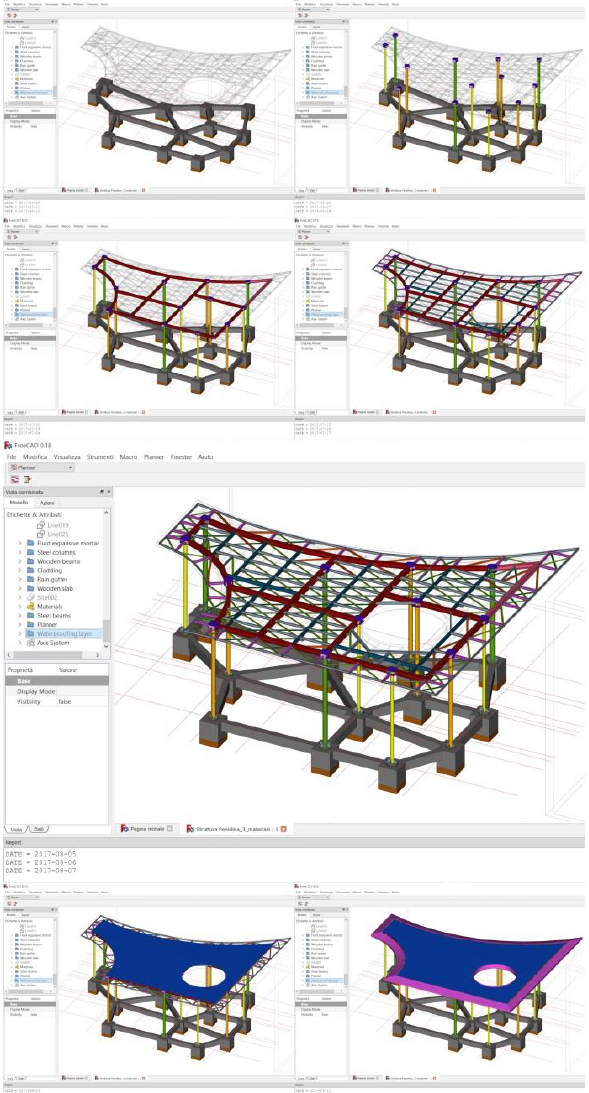
Figure 8. Building phases in Freecad according to the Gantt Diagram exported from